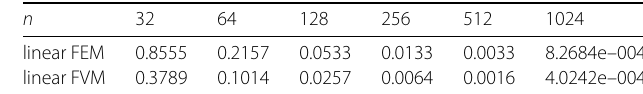
Table 4 The error in the relative discrete H 1 -seminorm for problem (5.1) with k = 30